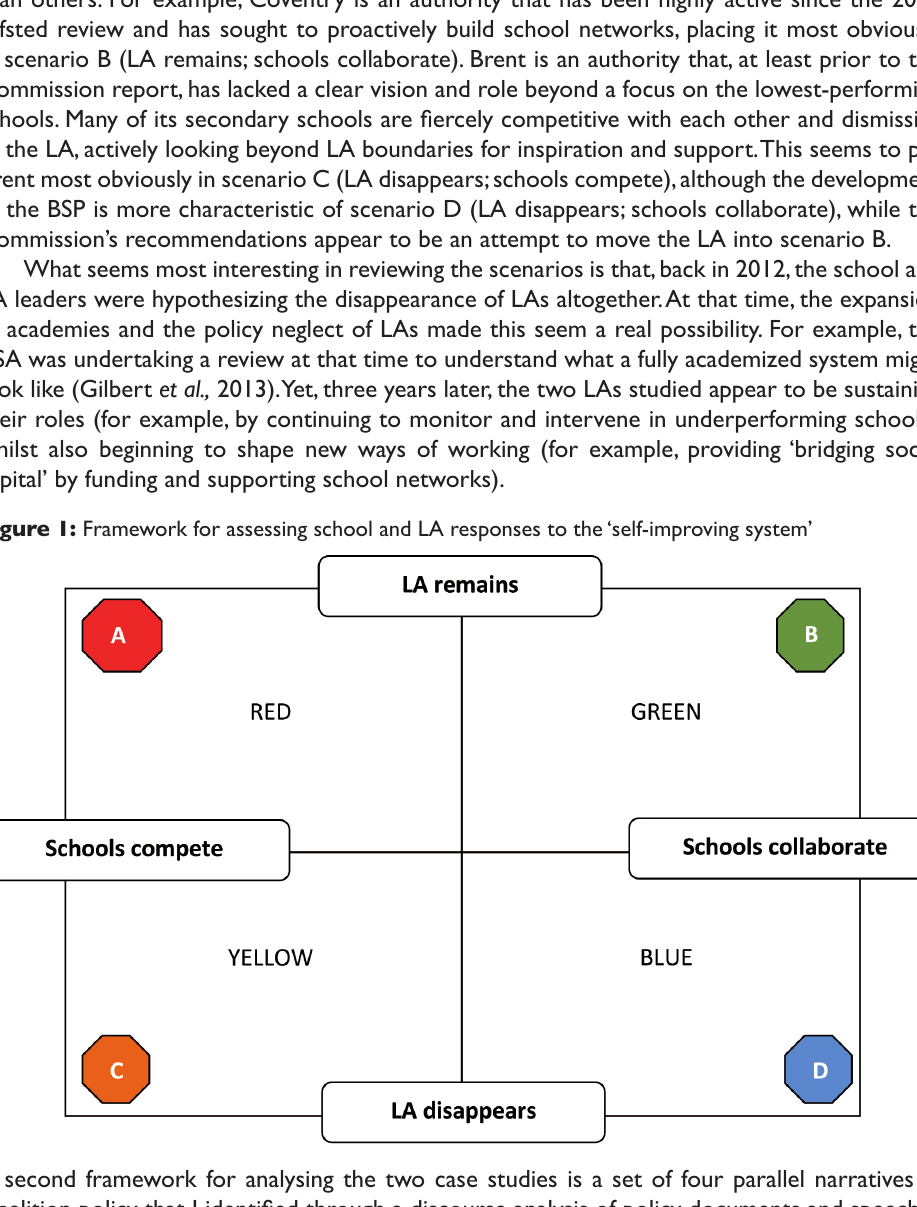
A second framework for analysing the two case studies is a set of four parallel narratives in Coalition policy that I identified through a discourse analysis of policy documents and speeches (Greany,